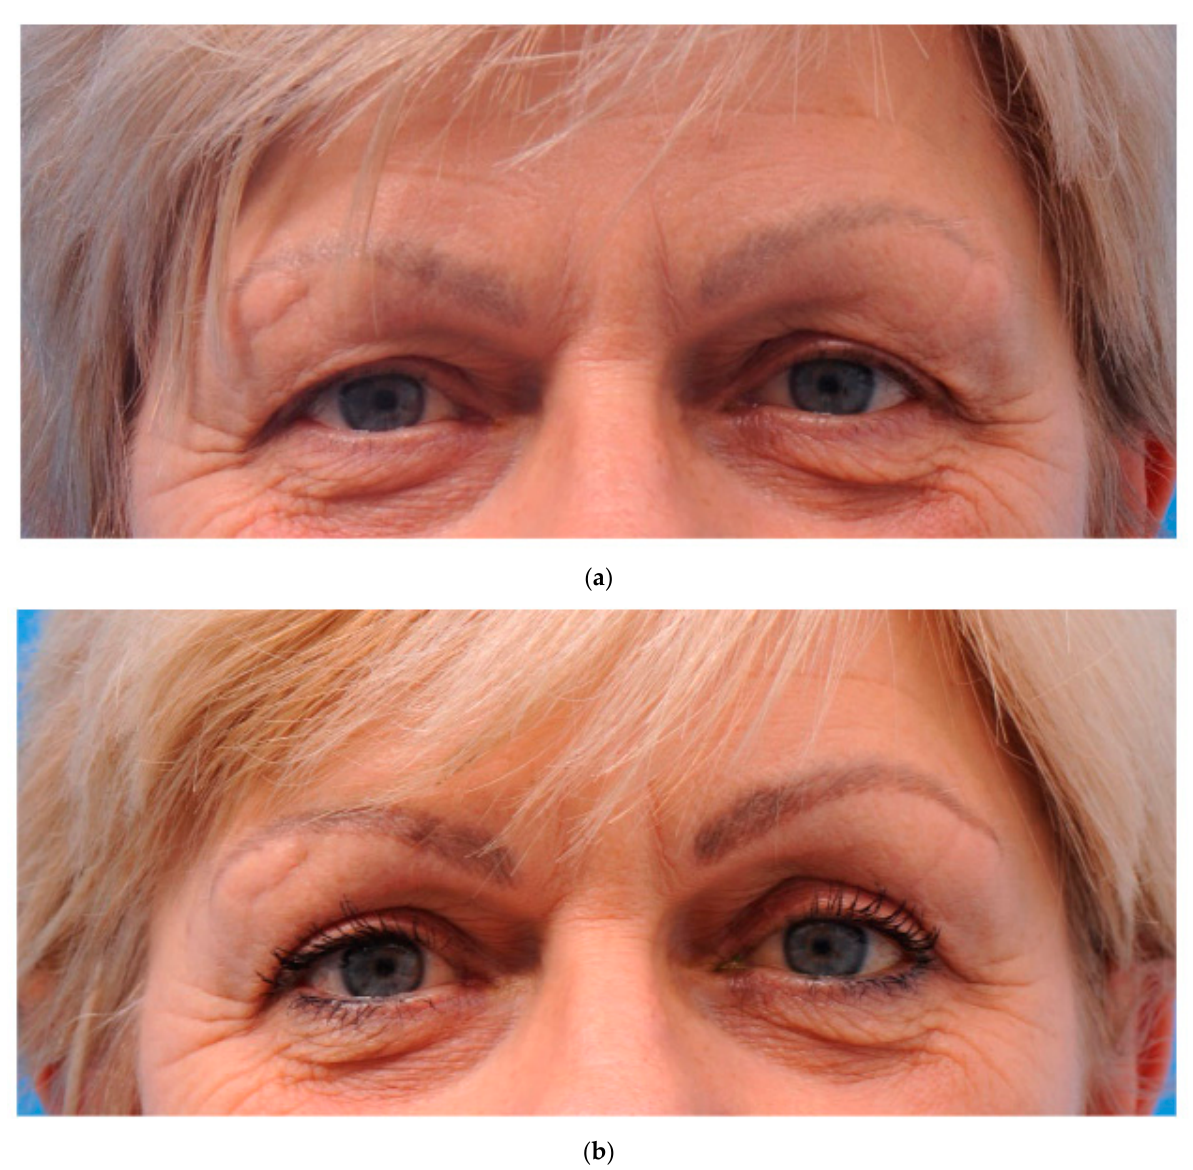
Figure 5. ( a ) Preoperative photograph of a participant from group A (skin only). ( b ) Photograph 12 months after upper eyelid blepharoplasty (group A; skin only).